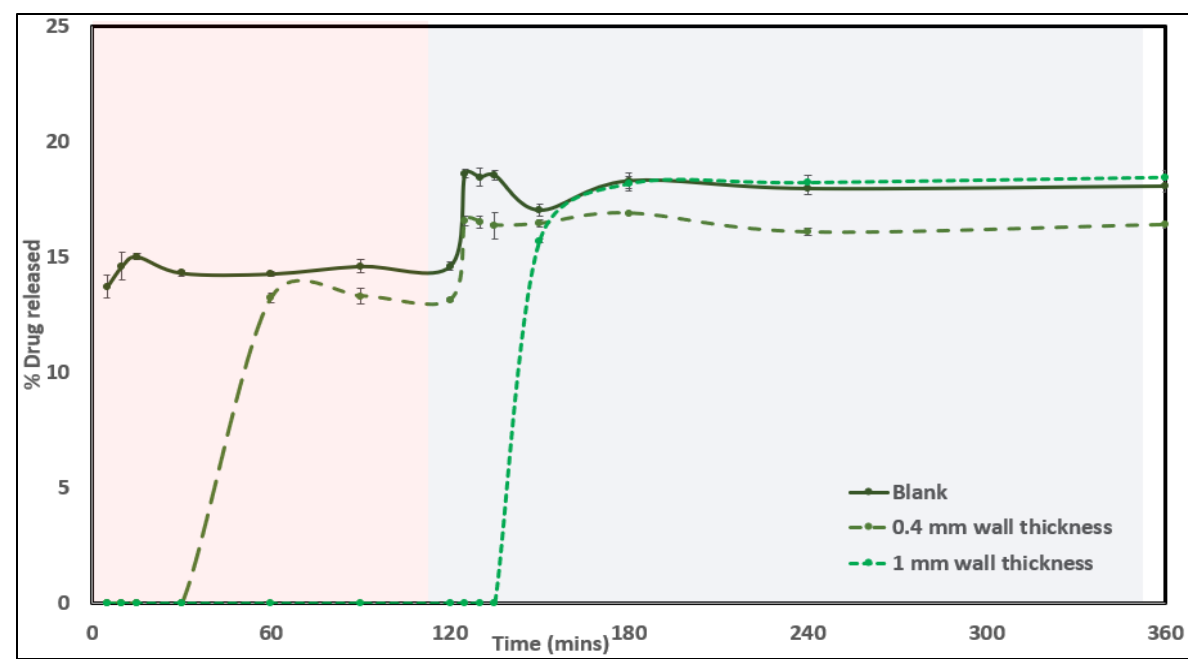
Figure 11. In vitro drug-release profile for curcumin from pure SNEDDS, SNEDDS tablets from 1 mm and 0.4 mm wall-diameter designs.